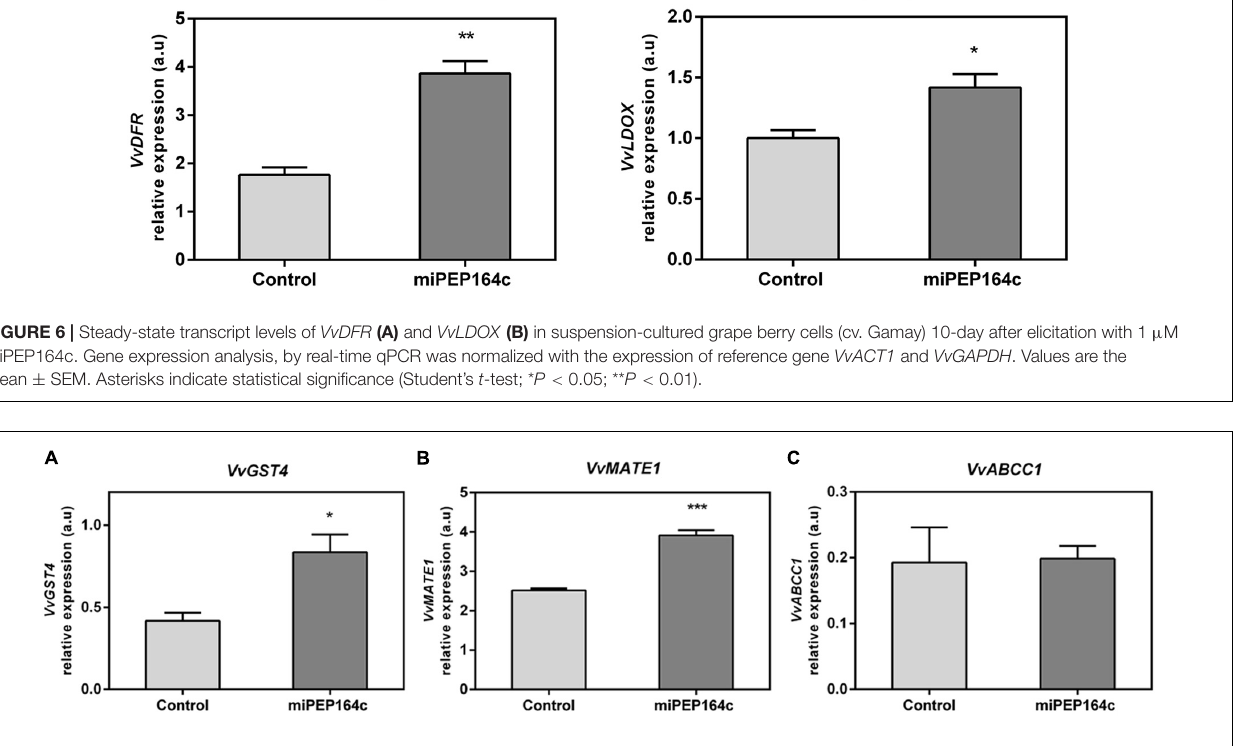
FIGURE 7 | Steady-state transcript levels of VvGST4 (A) , VvMATE1 (B) and VvABCC1 (C) in suspension-cultured grape berry cells (cv. Gamay) 10-day after elicitation with 1 µ M miPEP164c. Gene expression analysis, by real-time qPCR was normalized with the expression of reference gene VvACT1 and VvGAPDH . Values are the mean ± SEM. Asterisks indicate statistical significance (Student’s t -test; * P < 0.05; *** P <